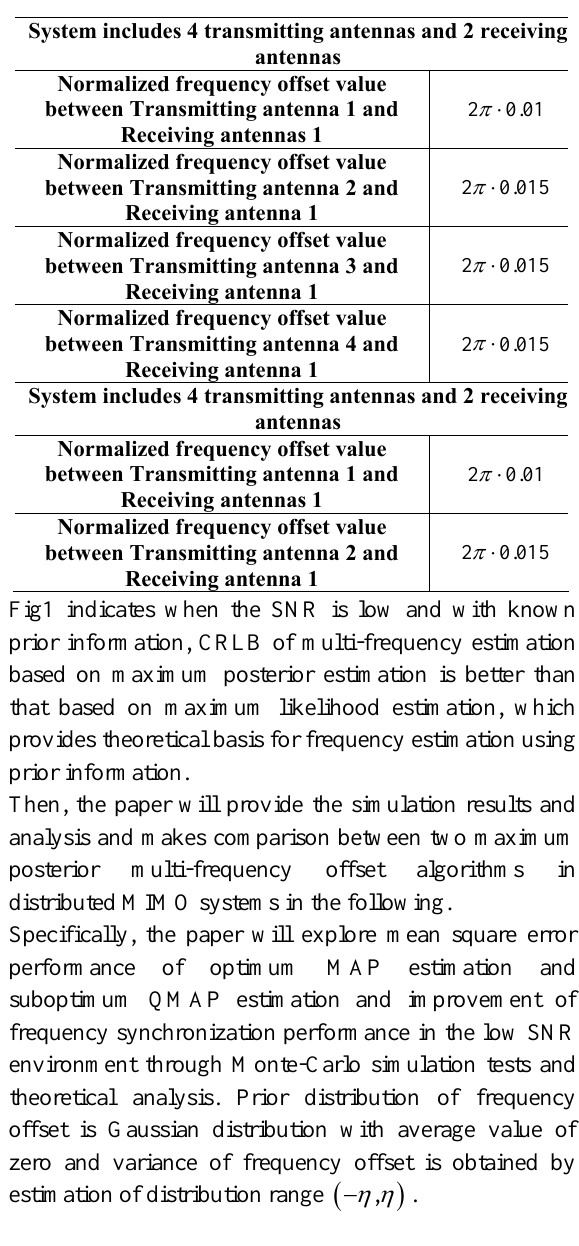
Table 1.Simulation condition for CRLB based on maximum likelihood and maximum posterior